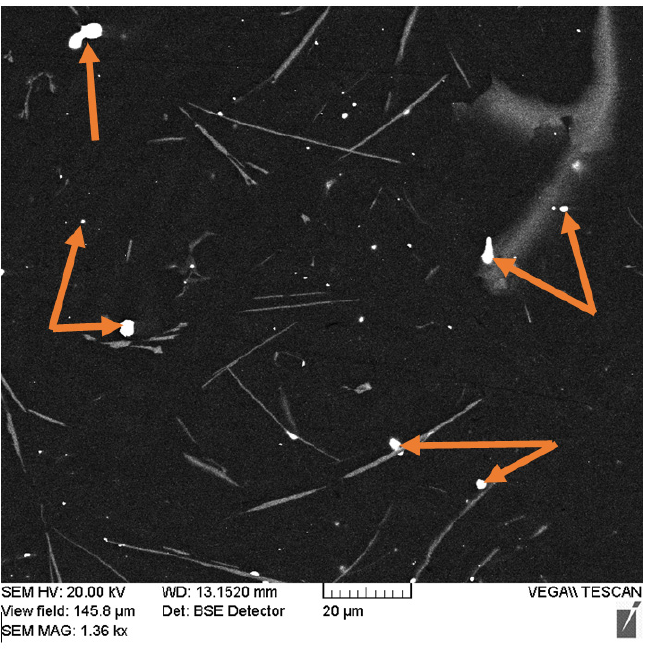
Figure 9. The microstructure of the middle part of the coating from the AlSi12 alloy with the lead sublayer.